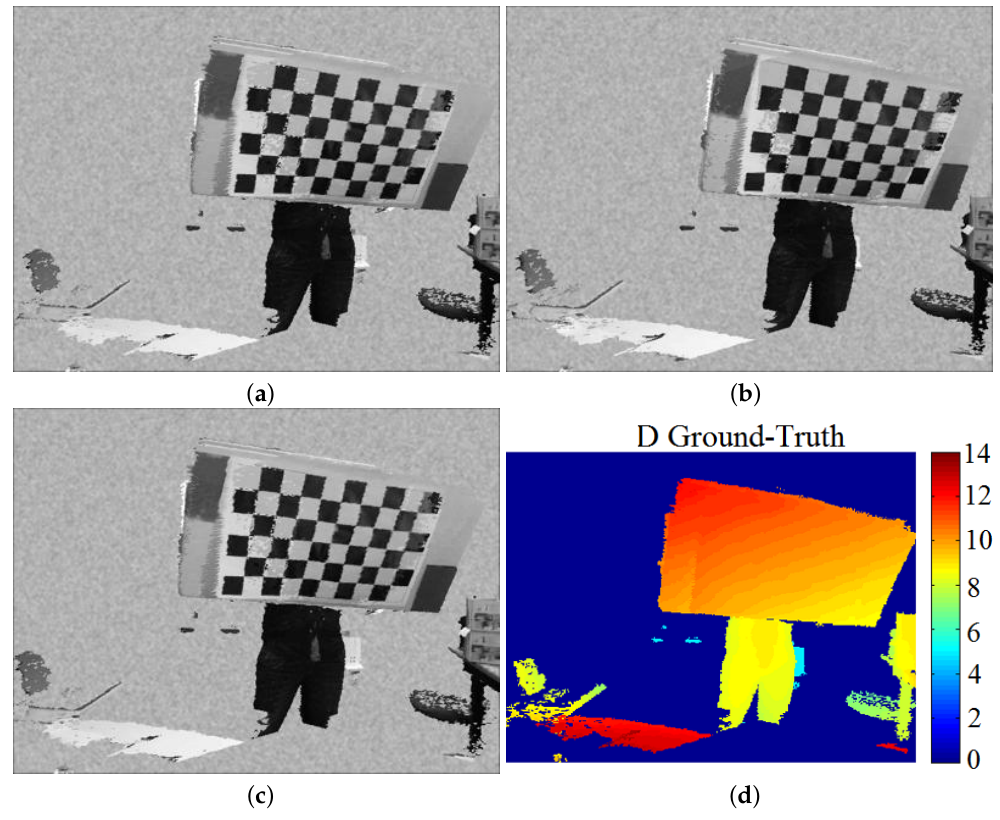
Figure 10. “Dimitris-Chessboard” sequence: ( a , b ) first and last (sixth) frame of the left view; ( c ) first frame of the right view; ( d ) ground-truth of